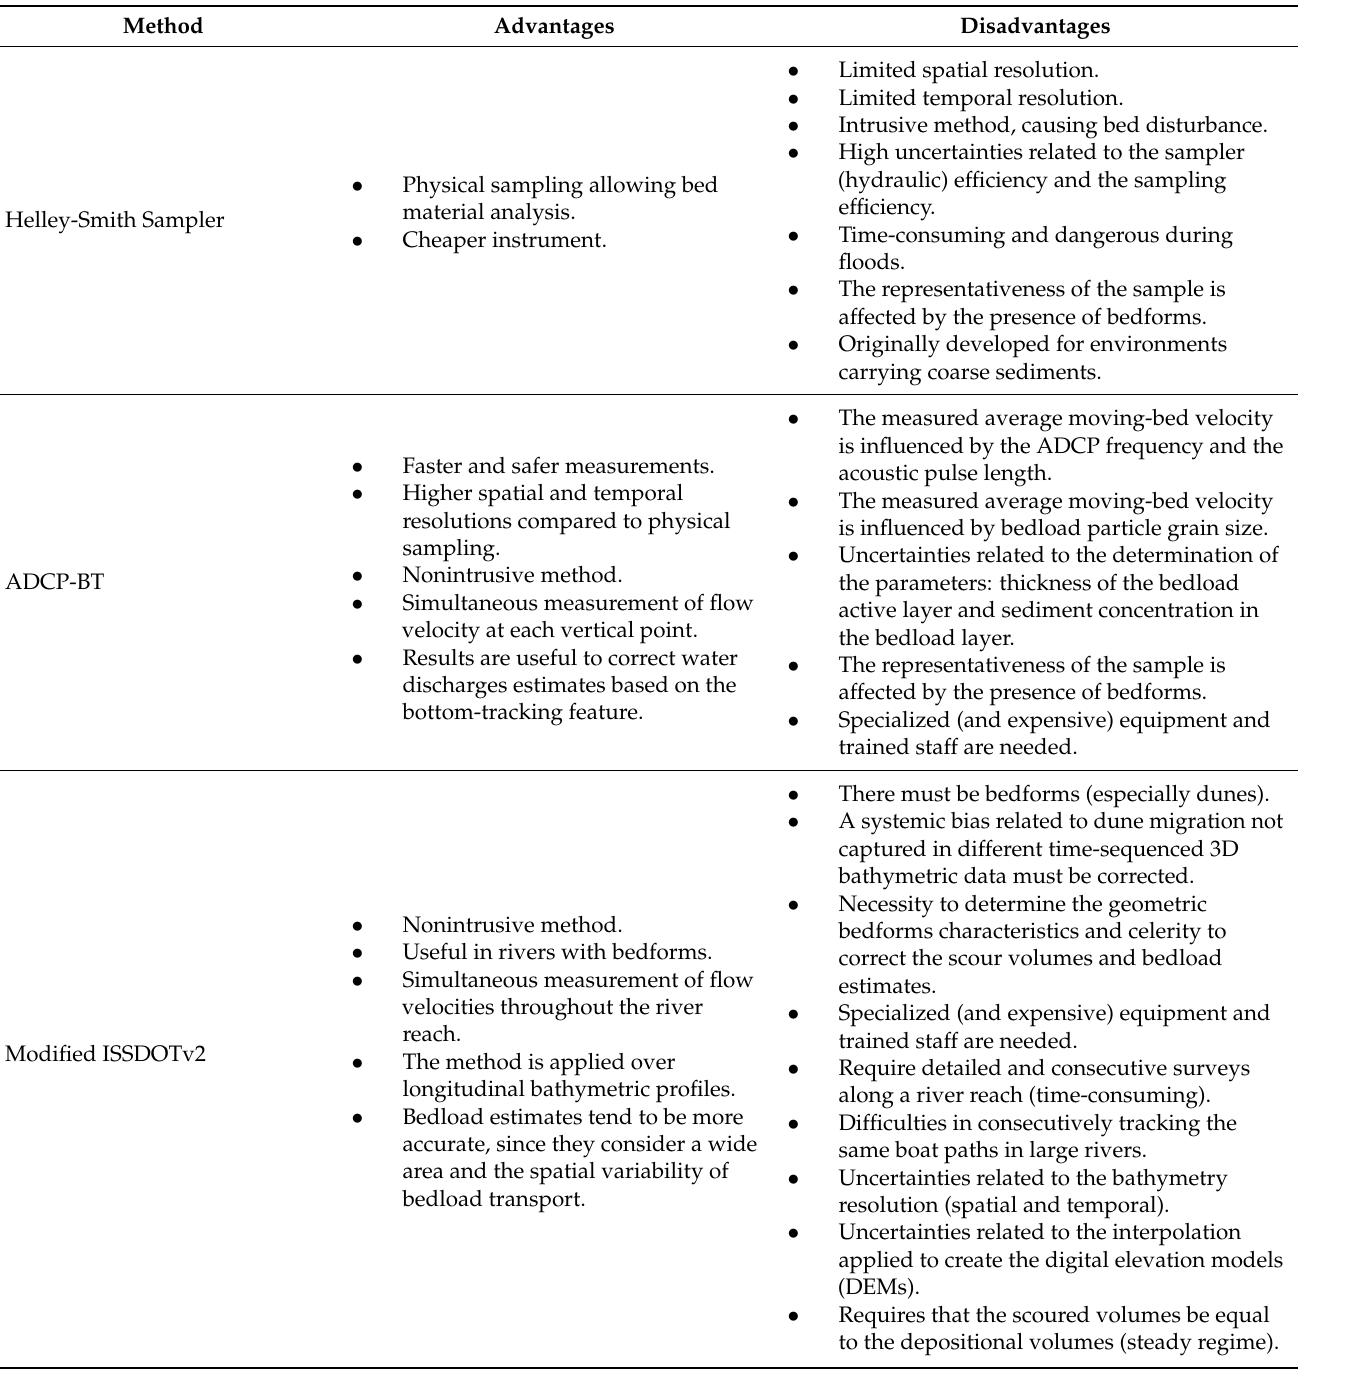
Table 4. Advantages and disadvantages of methods applied to estimate bedload sediment transport in sand-bed rivers with